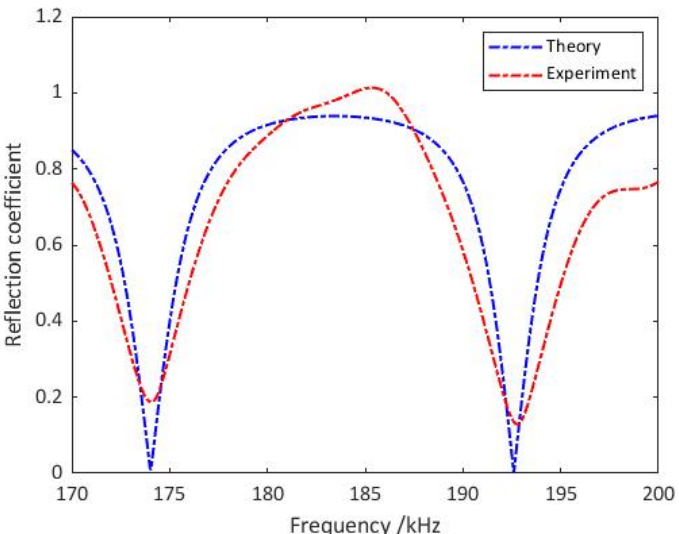
Figure 8. Comparison of experimental measurements and theoretical reflection coefficient when the middle layer is pure water.